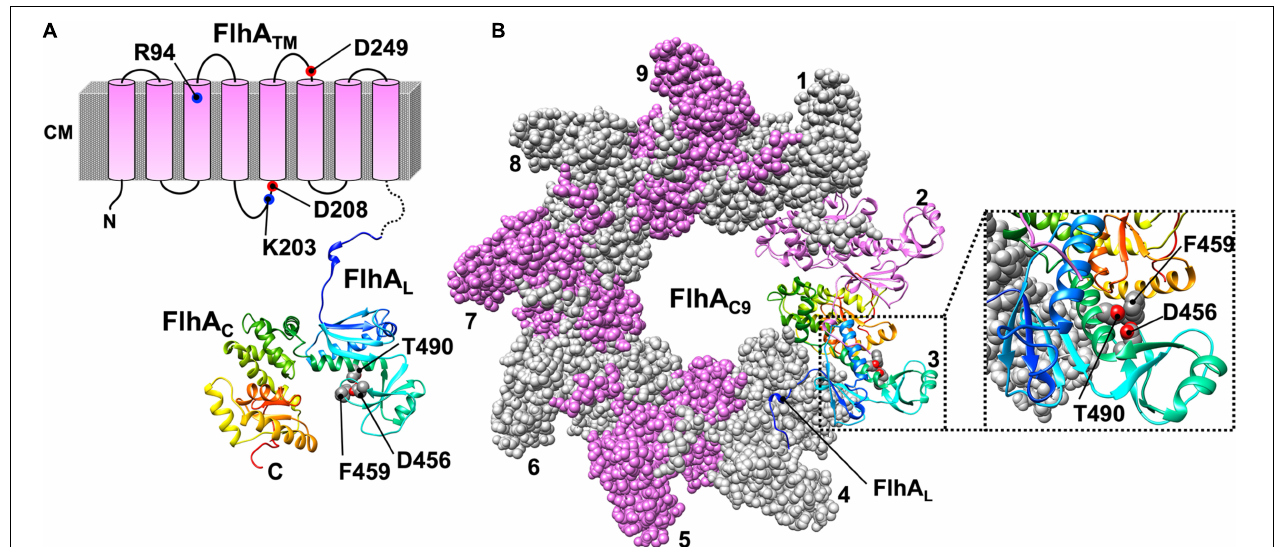
FIGURE 4 | Atomic model of the cytoplasmic domain of FlhA (PDB ID: 3A5I). (A) Topological model of FlhA. FlhA is composed of an N-terminal transmembrane region with eight transmembrane helices (FlhA TM ) and a large C-terminal cytoplasmic domain (FlhA C ). FlhA TM acts as a dual-ion channel that can conduct both H + and Na + . The highly conserved charged residues R94, K203, D208 and D249 are involved in H + -coupled protein export. The highly conserved residues D456, F459 and T490 of FlhA C are critical for substrate recognition. A flexible linker region of FlhA (FlhA L ), which connects FlhA C with FlhA TM , is involved in the interaction with FliJ. The interaction between FlhA L and FliJ activates the FlhA ion channel. (B) Model of the FlhA C -ring. FlhA C forms a homo-nonameric ring structure. The C-terminal part of FlhA L binds to the neighboring FlhA C subunit to stabilize the open conformation of FlhA C , allowing flagellar export chaperones in complex with their cognate substrates to bind to a chaperone-binding site of FlhA C , which includes the D456, F459, and T490